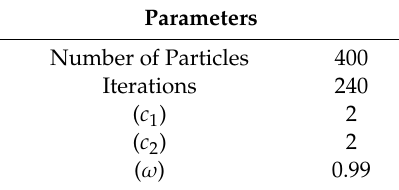
Table 1. The parameters of PSO algorithm for optimizing artificial neural networks